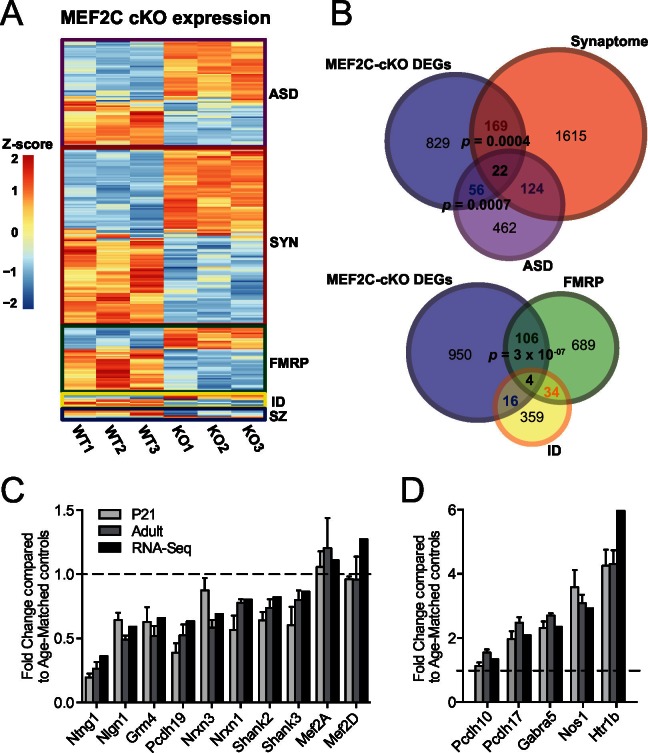
Characterization of Mef2c cKO RNA-Seq differentially expressed genes.(A) Heatmap showing the disorder-related genes differentially expressed in Mef2c cKO (KO) compared with wild-type (WT). In red, genes with higher expression; in blue, genes with lower expression. (B) Overlap between Mef2c cKO DEGs and gene sets of interest. Marked, the overlap p-values. Number of genes for each gene sets are indicated. (C) Relative expression of selective down-regulated ASD-associated genes from Mef2c cKO DEGs compared to controls. Both RNA-Seq and qPCR (P21 and Adult) show similar expression changes for most genes. (D) Relative expression of selective up-regulated Mef2c cKO DEGs compared to controls. Both RNA-Seq and qPCR (P21 and Adult) show similar expression changes. Data are represented as mean ± SEM. See Materials and methods for statistical analysis. n=3 animals/genotype for RNA-Seq; n=6 animals/genotype for adult qPCR; n=6 control and n=4 Mef2c cKO for P21 qPCR. Also see Table 1, Supplementary file 1 and Figure 4—figure supplement 1.